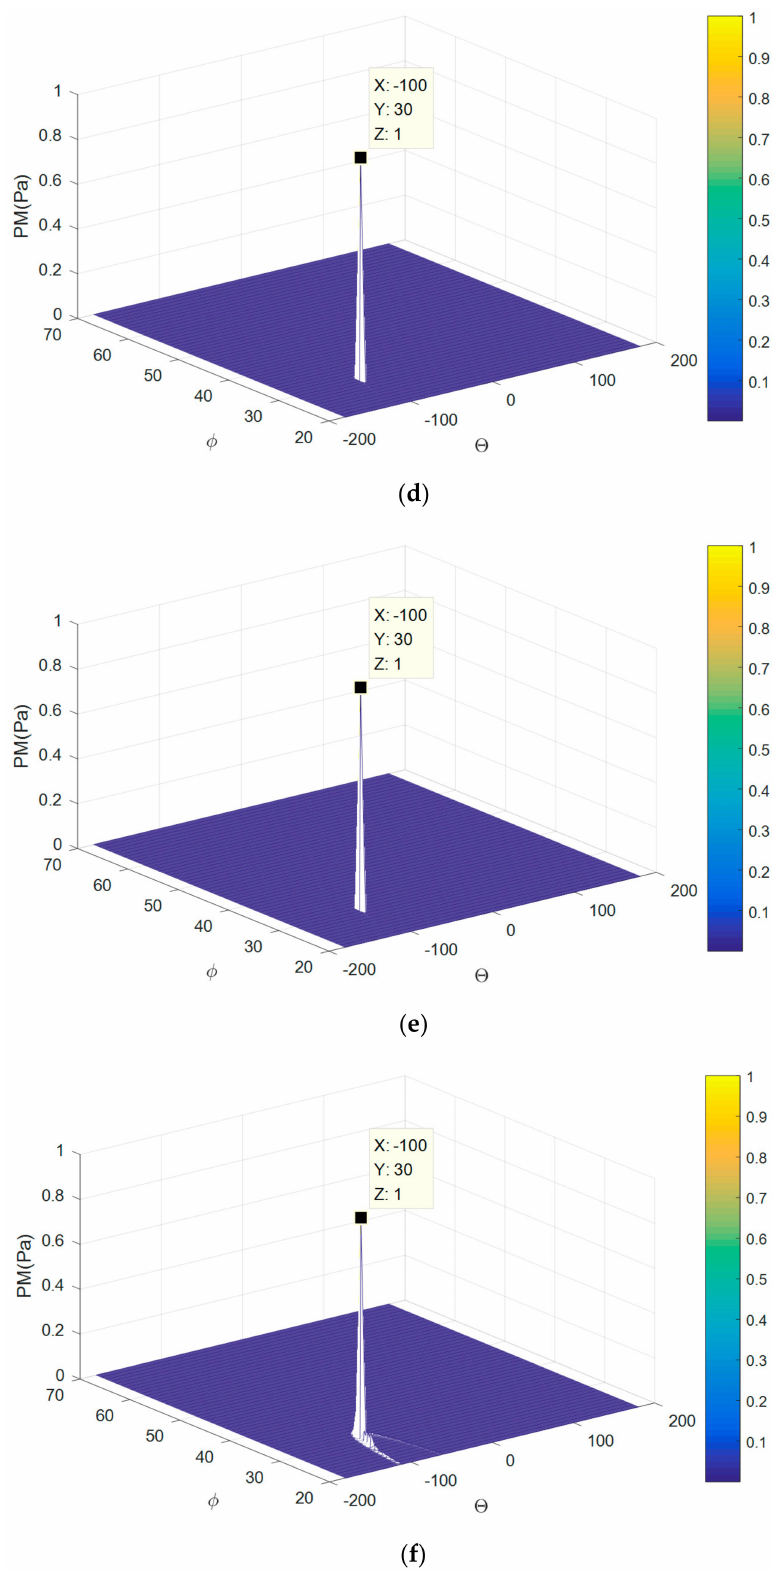
Figure 6. Source ( θ , ϕ ) = ( − 100, 30) estimation in high noise environments with ( a ) SNR = 12 dB, ( b ) SNR = 6 dB, and ( c ) SNR = 0 dB for the original MUSIC method and ( d ) SNR = 12 dB, ( e ) SNR = 6 dB, and ( f ) SNR = 0 dB for the VAD + MUSIC